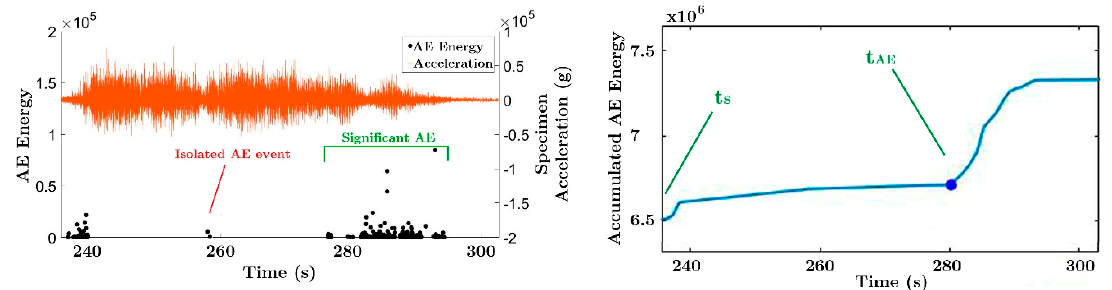
Figure 12. AE SIGN (left) and the accumulated AE energy (right) during the C200b. ECB, specimen 294